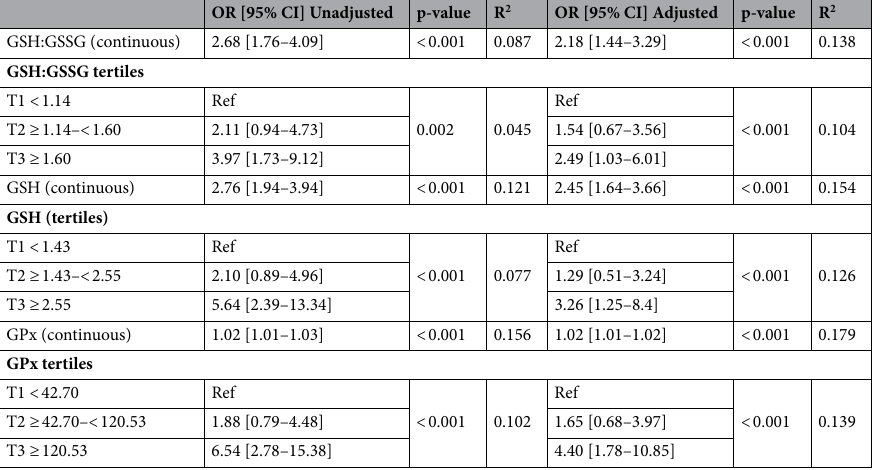
Table 6. Association between anemia and redox status. Anemia was used as a binary variable (anemic vs. non- anemic); the non-anemic group was used as a reference in logistic regression. The adjusted model is adjusted for age, sex, and BMI categories. GPx glutathione peroxidase, Hb hemoglobin, OR odds ratio, CI confidence interval, GSH reduced glutathione, SD standard deviation, GSSG glutathione disulfide, BMI body mass index, WC waist circumference, Ht height.